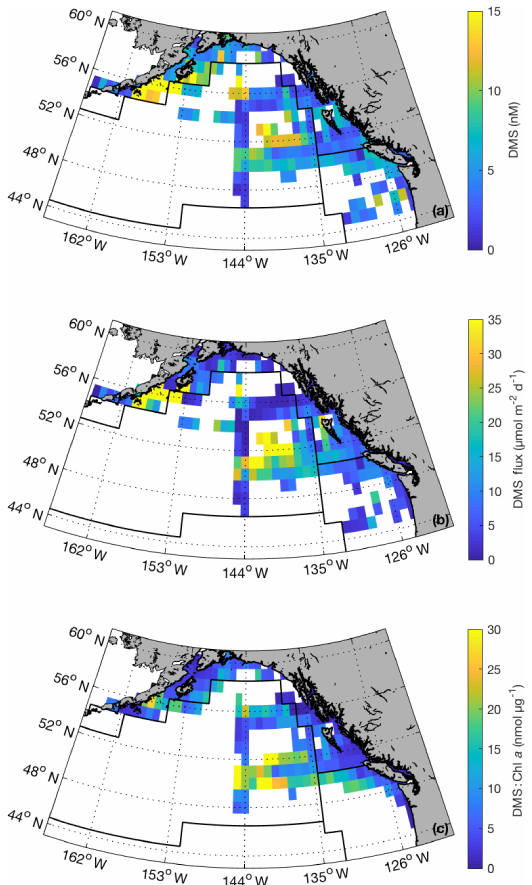
Figure 10. Summertime DMS concentrations (a) , DMS sea–air fluxes (b) and DMS : Chl a ratios (c) binned to 1 ◦ × 1 ◦ spa- tial resolution. These maps were derived using our combined PMEL–MIMS data set (1984–2017; June, July and August). Black lines correspond to boundaries of Longhurst biogeochem- ical provinces (see Fig. 8 for province names). Maximum values (47nM, 180µmolm − 2 d − 1 and 47nmolµg − 1 for panels a , b and c , respectively) exceed the bounds of the colour bars. Maximum val- ues for DMS and DMS flux occur in the waters south of the Alaska Peninsula, whereas maximum DMS : Chl a occurs